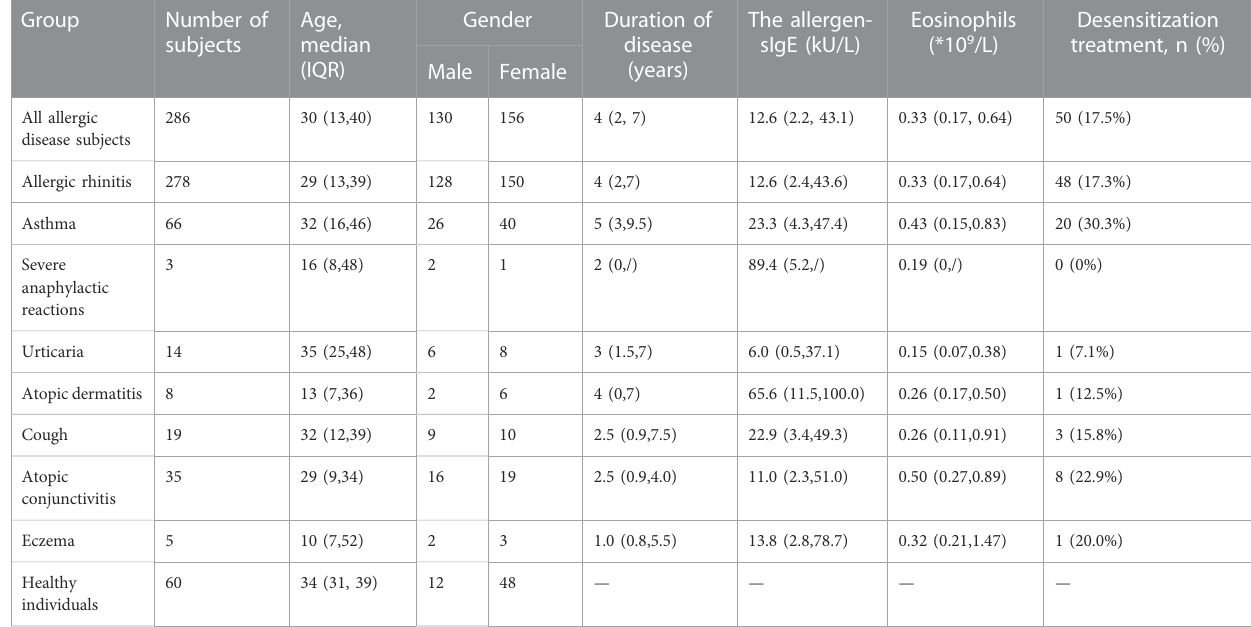
TABLE 1 The demographic characteristics of the participants in this